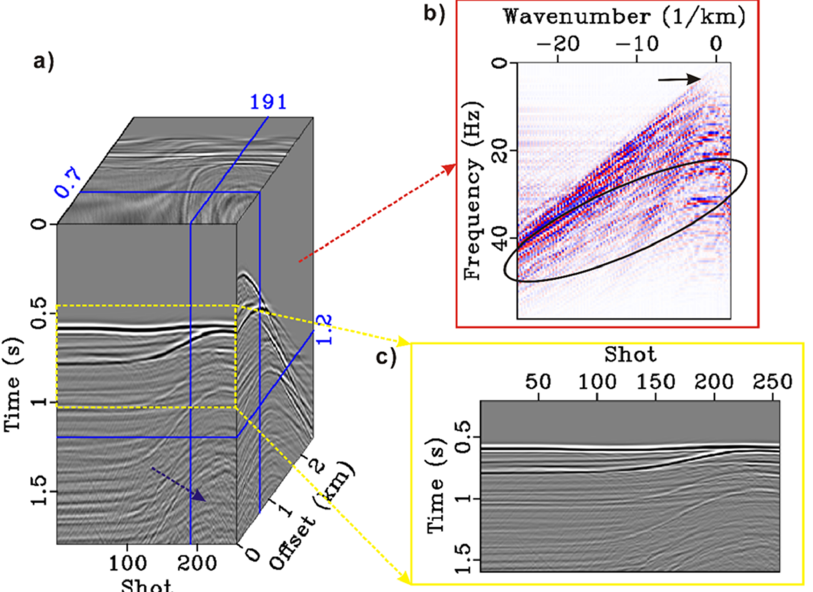
Figure 7. The conventional deghosting results. ( a ) 3D data cube including 256 CSGs and 256 COGs. ( b ) f - k spectrum in which the black oval marks the effect of ghost. ( c ) COG wherein the events are similar to the underground interface.